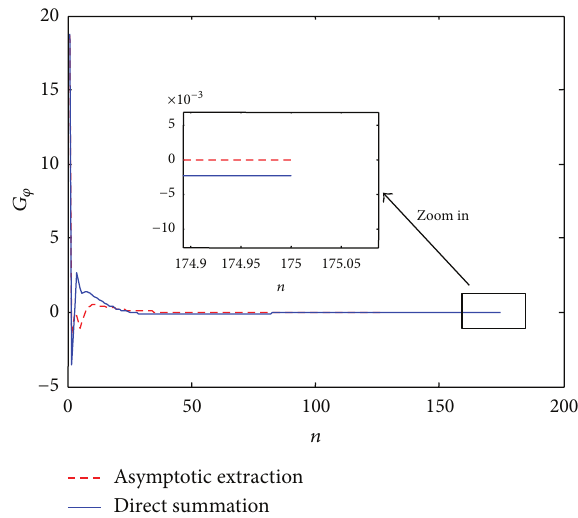
Figure 7: Convergence of 𝐺 12 𝜑 when source is located in the patch and field locate in the probe.